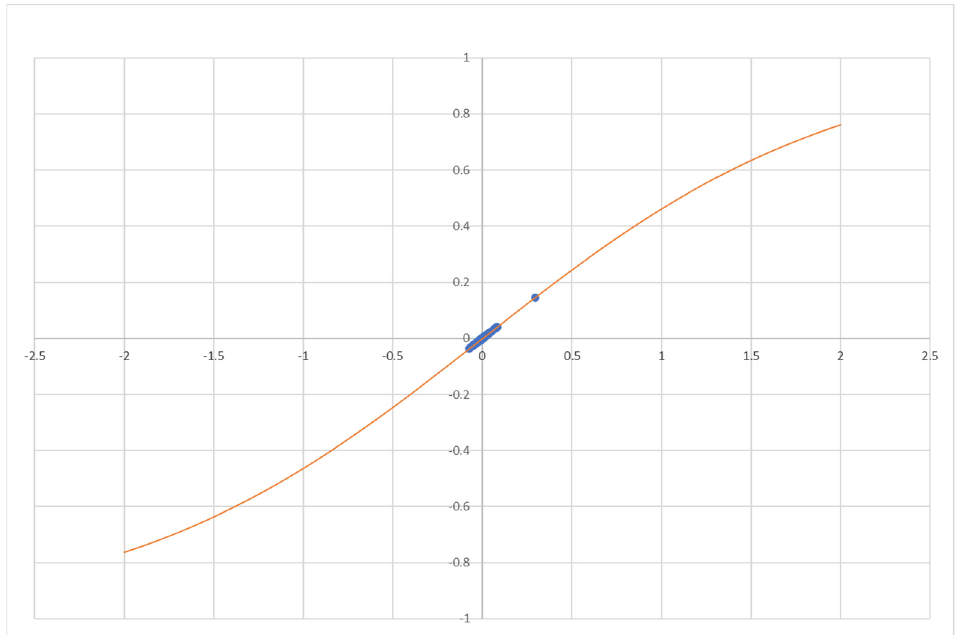
Figure 2. The positioning of the 142 sampled banks over the curve of BTIR-transformation. Authors’ development.